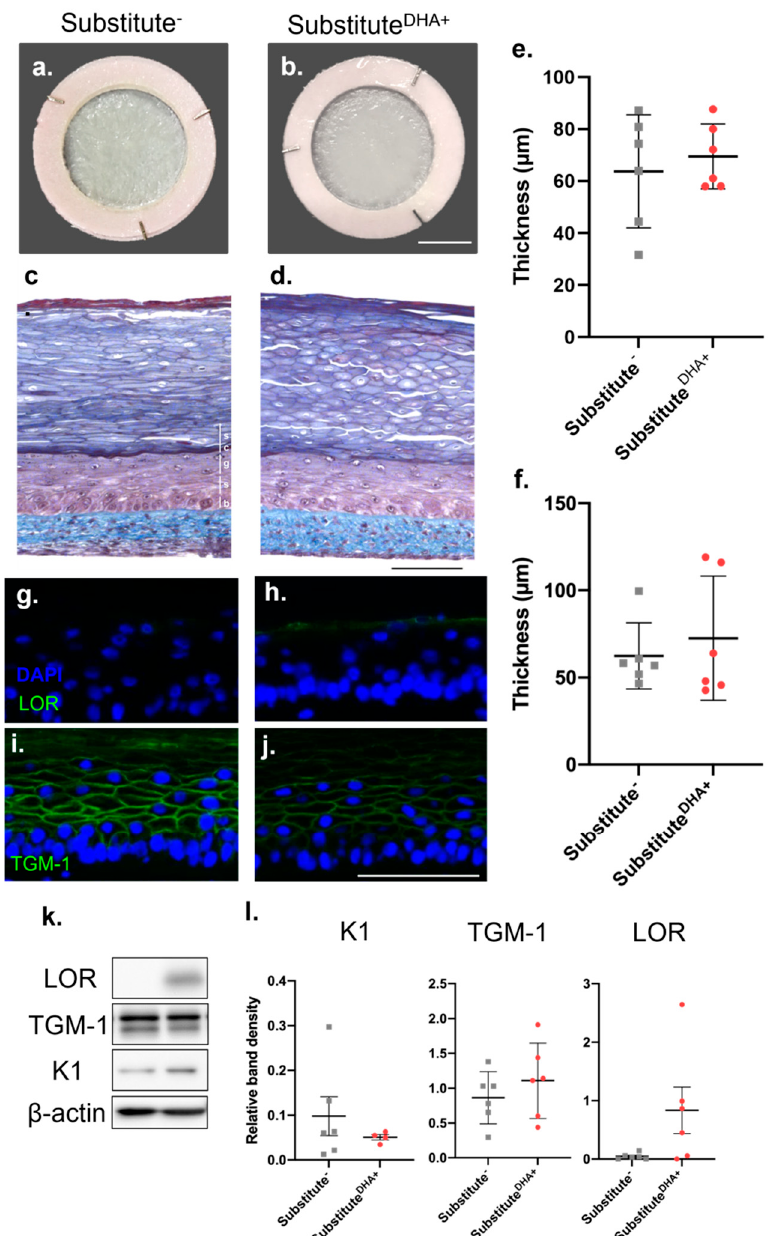
Figure 1. Influence of DHA supplementation on the skin substitutes’ morphology. ( a , b ) Macroscopic aspect and ( c , d ) histological cross-section following Masson’s trichrome staining of the skin substitutes. (b: basal layer, s: spinous layer, g: granular layer and sc: compact layers of the stratum corneum.) Scale bars: ( a , b ) 1 cm, ( c , d , g – j ) 100 μ m. ( e ) Epidermal and ( f ) dermal thickness quantified from Masson’s trichrome-stained sections using ImageJ software. ( g , h ) Immunofluorescence staining of Lor (green) and ( i , j ) TGM-1 (green) with nuclei stained in blue with DAPI. ( k ) Western blot analysis of differentiation markers in the epidermis of skin substitutes followed by ( l ) quantification of signals for relative band densities using ImageJ Software. n = 6 (3 donors, 2 skin substitutes per donor, 3 measurements per skin substitute). The p -values were derived from Student’s t-tests and considered statistically significant when p < 0.05. Abbreviations: Lor, loricrin; TGM-1, transglutaminase-1; K1, keratin 1.